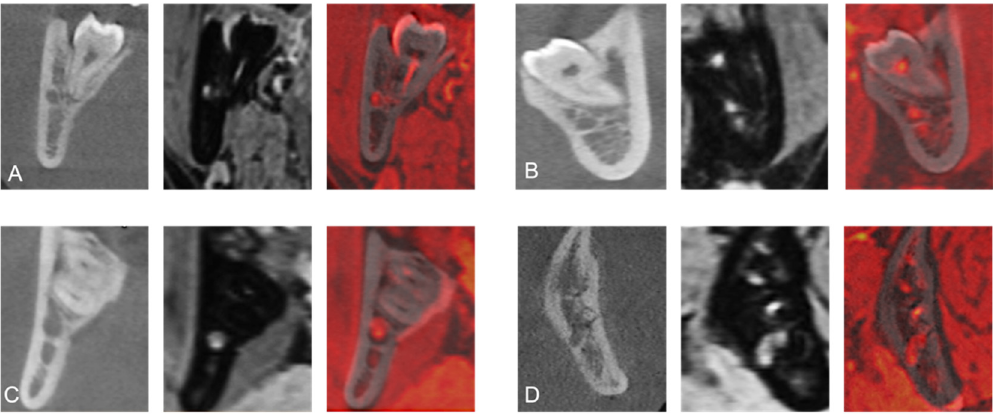
Figure 3. Coronal reconstruction of a study participant’s CBCT, 3D ‐ DESS MRI, and fused CBCT/MRI images visualizing periradicular (buccal ( A ); lingual ( B ); inferior ( C )) or interradicular (between the roots ( D )) relative positional relationship of the IAN at the third molar.